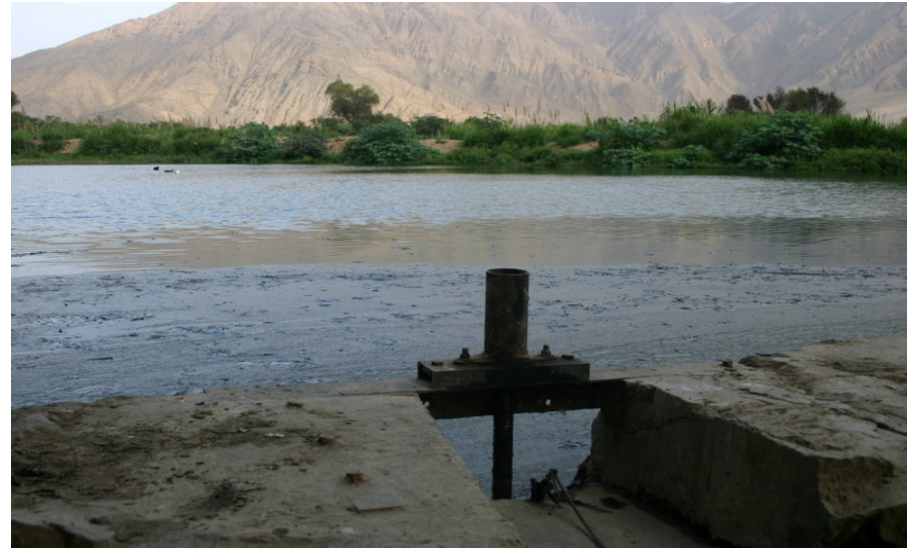
Figure 11. Major reservoir interior to the Supe Valley derived from groundwater penetration into a low-lying area.